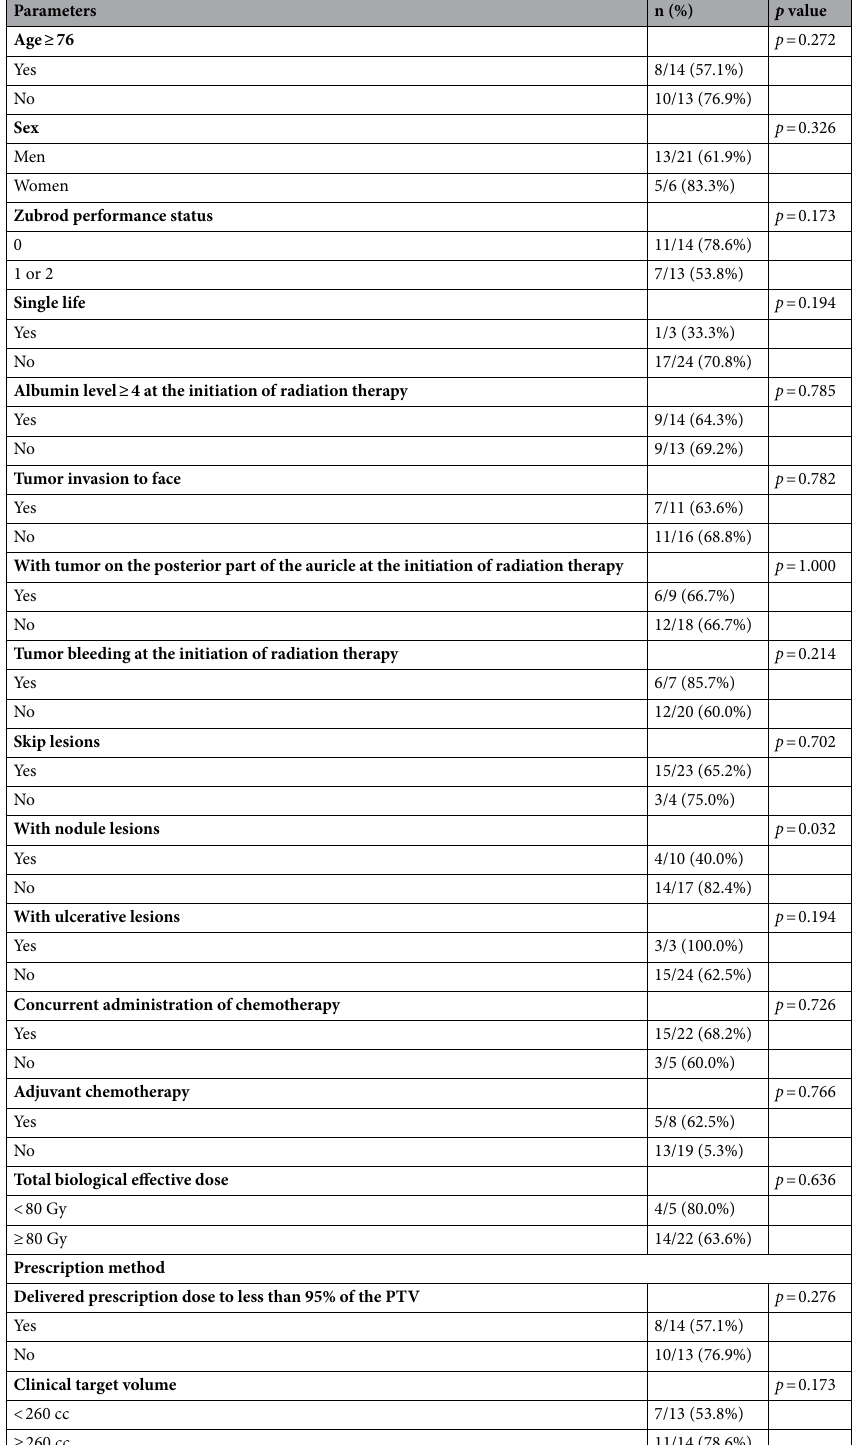
Table 2. Analyses of predictive factors on acute radiation dermatitis ≥ grade 3. PTV*, planning target